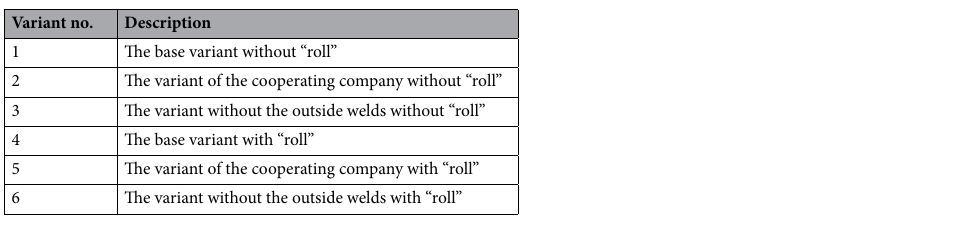
Table 7. Description of the FEM simulation variants.